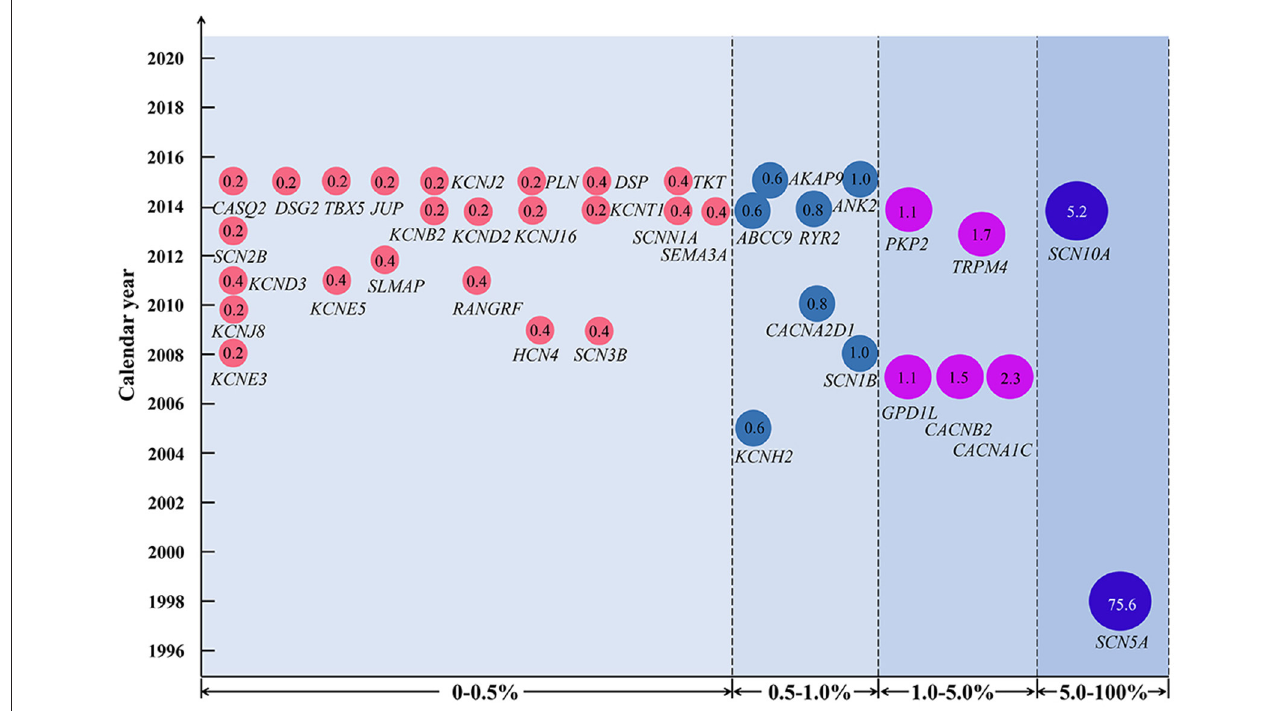
FIGURE 5 | Variant frequency of genes related to Brugada syndrome (BrS). Each disease-causing or susceptibility gene corresponds to the year when it was first discovered to be related to BrS. The number in the circle indicates the percentage of variant frequency. The gene symbol used is approved by the HUGO Gene Nomenclature